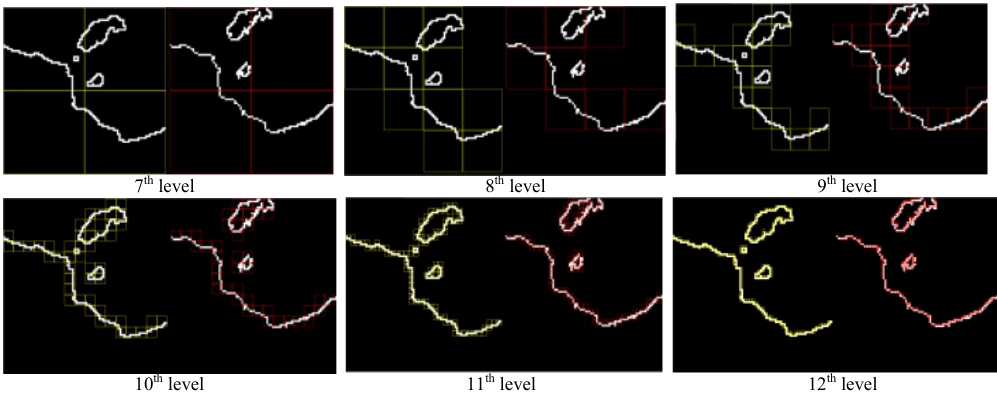
Figure 4. Multi-level grids matching algorithm (take the image in column 51 of line 42 as an example)